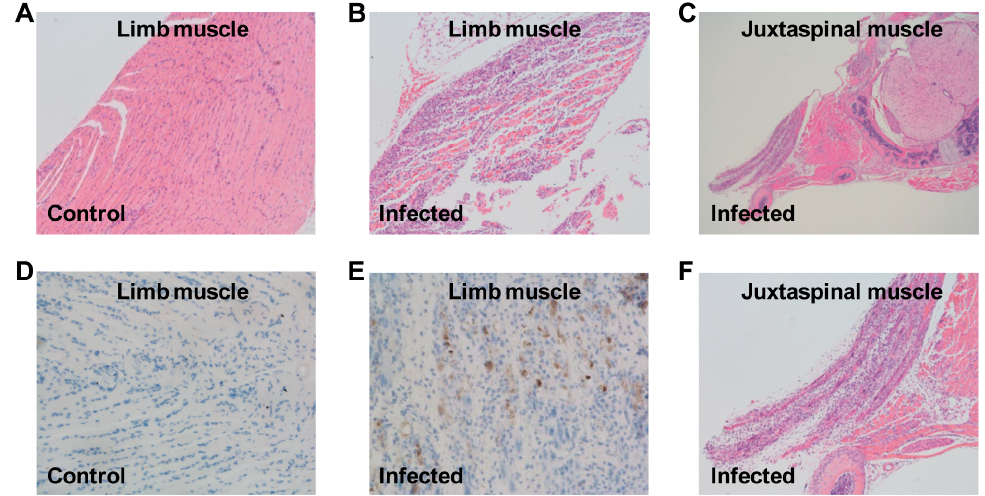
Figure 5. Histological examination of EVD68-infected mice. One-day-old ICR mice were inoculated i.p. with ( A , D ) culture medium or ( B , C , E , F ) 1.2 × 10 5 TCID 50 of US/MO/14-18947. Tissues were collected at day 7 after inoculation and then subjected to ( A – C , F ) H&E staining or ( D , E ) immunohistochemical staining with an anti-EVD68 mAb 6A11 as the primary antibody; ( F ) expanded view of panel ( C ). Magnification: panels ( A , B , F ): × 100; panel ( C ): × 40; panels ( D , E ): × 200. Images shown are representative of two ICR mice in each group.